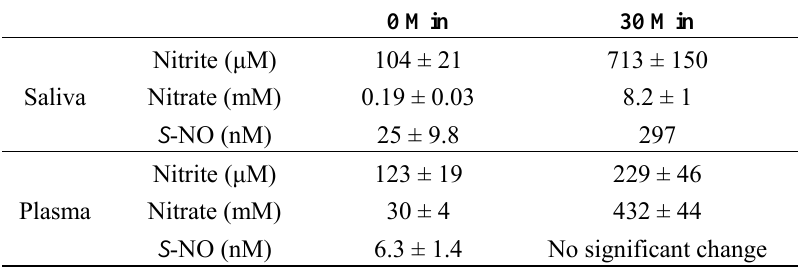
Table 2. Saliva and plasma levels of nitrite, nitrate, and S -nitrosothiol before and 30 min after oral administration of sodium nitrate (10 mg/kg) in healthy